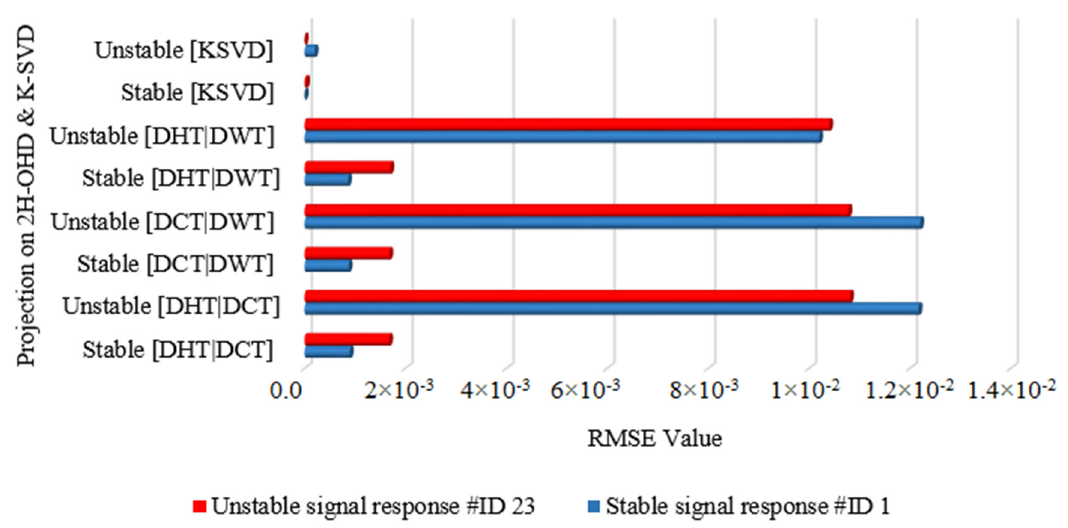
Figure 8. Projections of signals ID 1 and ID 23 on stable and unstable 2H-OHD and ADL.